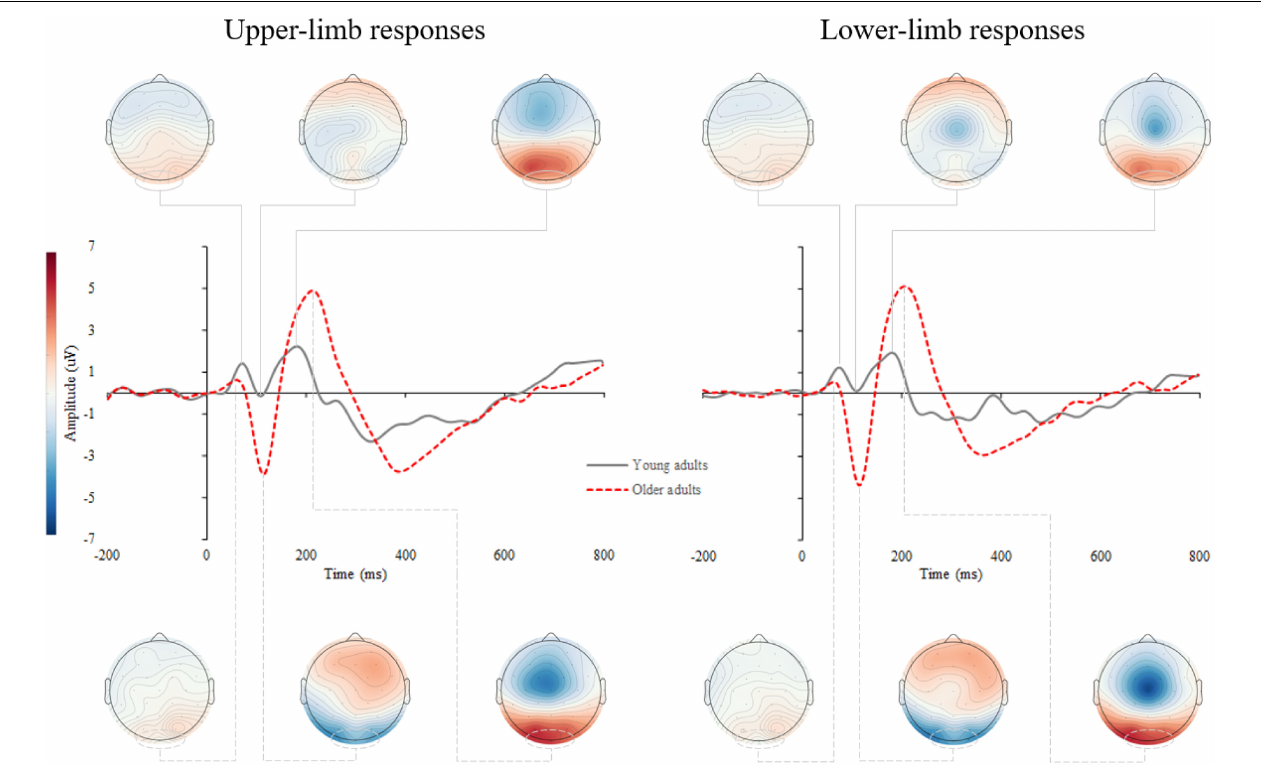
FIGURE 3 | Grand average stimulus-locked event-related potentials (s-ERPs) for upper- (left) and lower-limb RT (right) for younger and older adults. The topographic maps correspond to the individual ERP components: P1, N1, and P2.